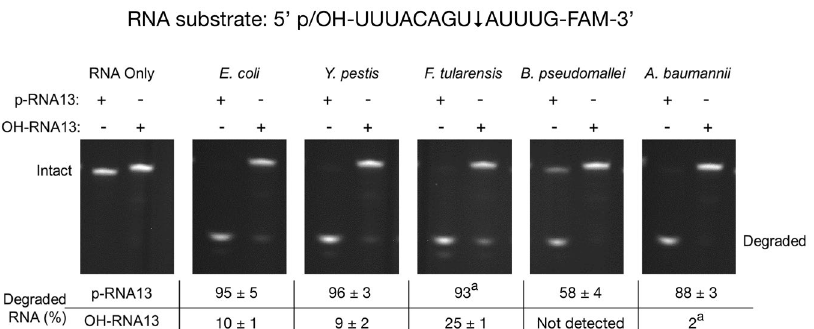
Figure 4. Cleavage of 5 ′ -p-RNA13-FAM-3 ′ and 5 ′ -OH-RNA13-FAM-3 ′ by RNase E NTDs. The sequence of the RNA substrates is shown, with an arrow indicating the expected cleavage site. 5 nM E. coli , Y. pestis , F. tularensis , B. pseudomallei or A. baumannii RNase E NTD were incubated with 1 μ M 5 ′ -p-RNA13-FAM-3 ′ (p-RNA13) or 1 μ M 5 ′ -OH-RNA13-FAM-3 ′ (OH-RNA13) at 28 °C for 45 minutes. Reaction products were resolved by 20% urea-PAGE and visualised using a G:Box UV transilluminator (Syngene). This figure is assembled from multiple gels that have been cropped. The uncropped gels are presented in Supplementary Fig. S5. The percentage of cleaved RNA present in each lane is indicated below the gels. Values are an average of three experiments, values have been rounded to the nearest whole numbers. Errors, where given, are the standard deviation to the nearest whole number ( a calculated error was below